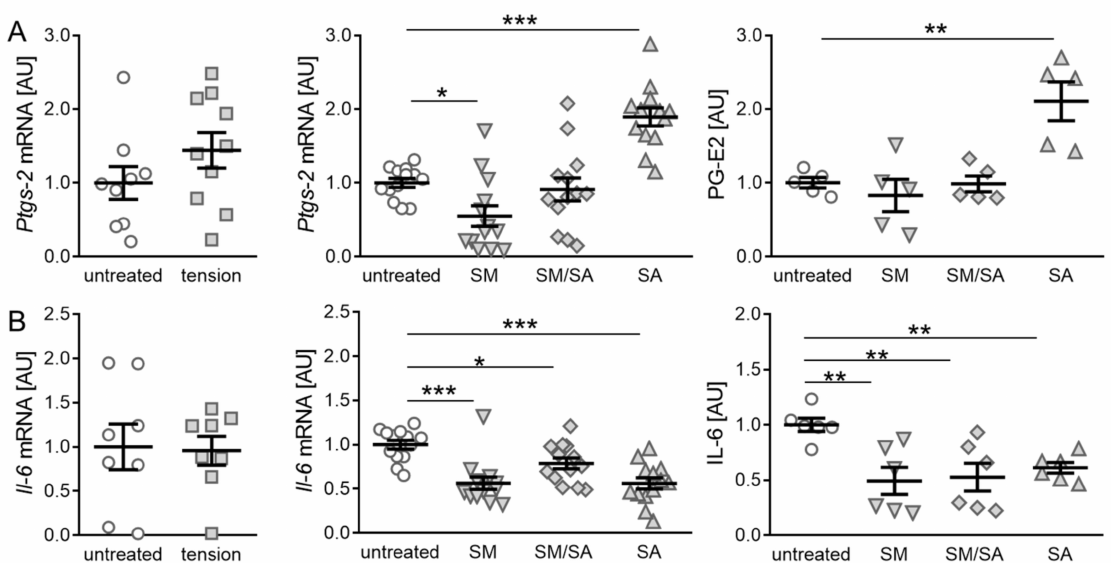
Figure 4. Synovial-fibroblast-mediated expression of inflammatory markers induced by various tensile loading protocols. Expression profiles of the inflammation indicator Ptgs-2 , PG-E2 ( A ), and the inflammatory cytokine IL-6 ( B ) induced by the short high-frequency tensile strain or prolonged tensile strain, respectively. AU: Arbitrary units; SM: Moderate; SM/SA: Intermediate; SA: Advanced. n ≥ 5, * p ≤ 0.05, ** p ≤ 0.01, *** p ≤